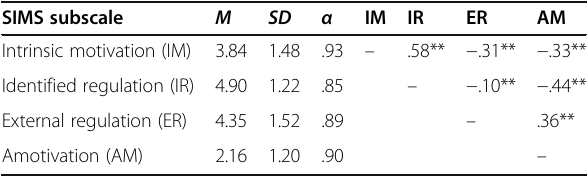
Table 2 Descriptive statistics, reliability, and bivariate correlations for subscale measures of the Situational Motivation Scale (SIMS) questionnaire. N =